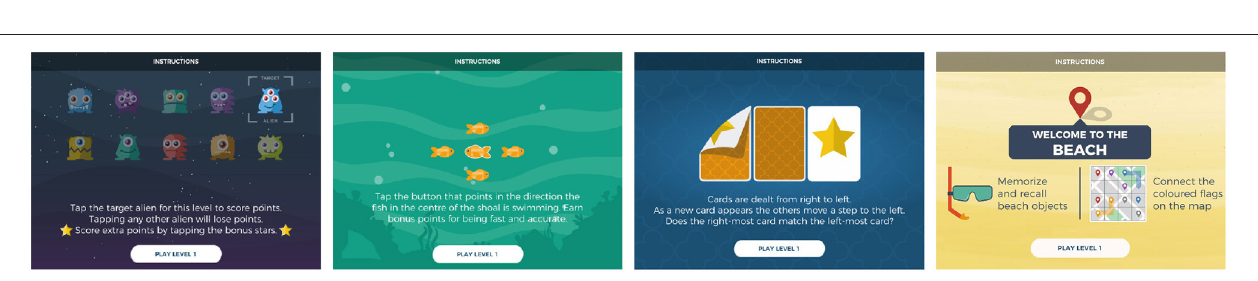
FIGURE 2 | Sixteen-channel wireless headset designed with pliable sensors and the sensor signal quality check.